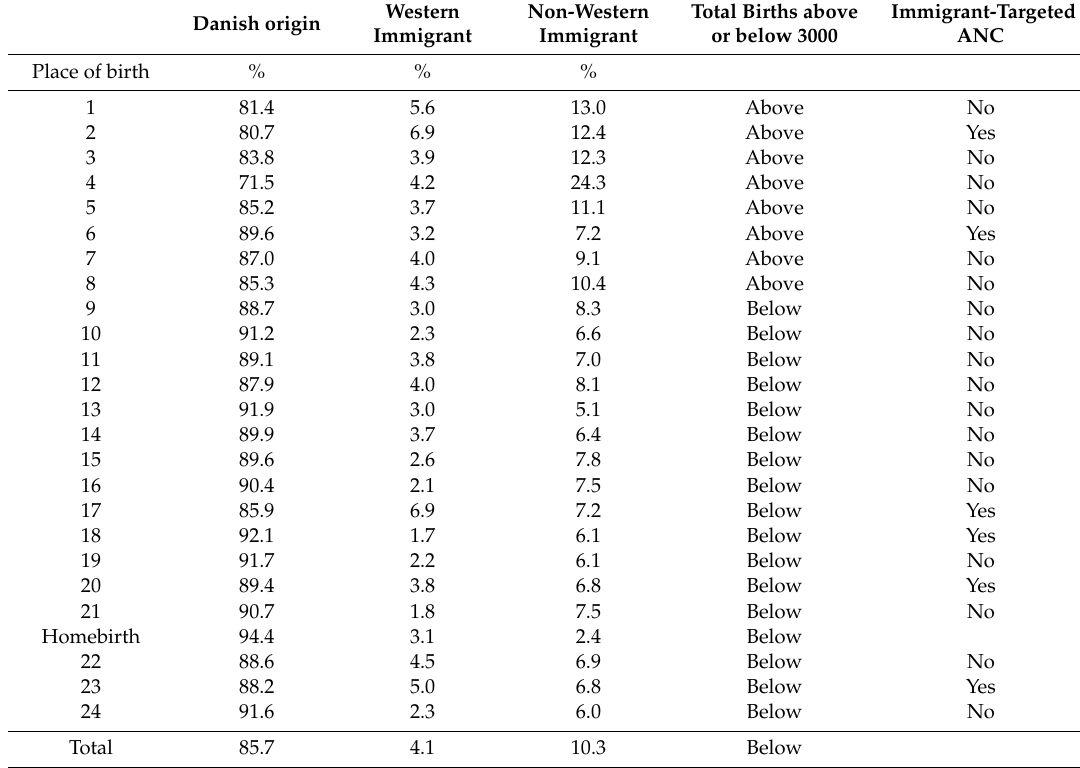
Table 2. Maternity wards in Denmark 2012: number of births by maternal origin in 2010 and immigrant-targeted antenatal care (ANC). Western Non-Western Total Births above Immigrant-Targeted Danish origin Immigrant Immigrant or below 3000